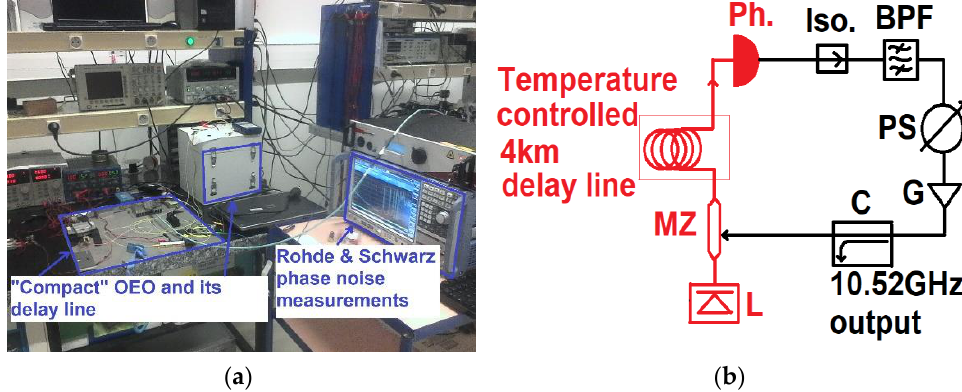
Figure 1. ( a ) Photo of the optoelectronic oscillator and the phase noise measurement commercial bench. ( b ) Optoelectronic oscillator (OEO): Optical and electrical elements are drawn in red and black colors, respectively. L—laser; MZ—Mach Zehnder modulator; Ph—photodetector; Iso—isolator; BPF—band pass filter; PS—phase shifter; G—microwave low noise amplifier; C—coupler.